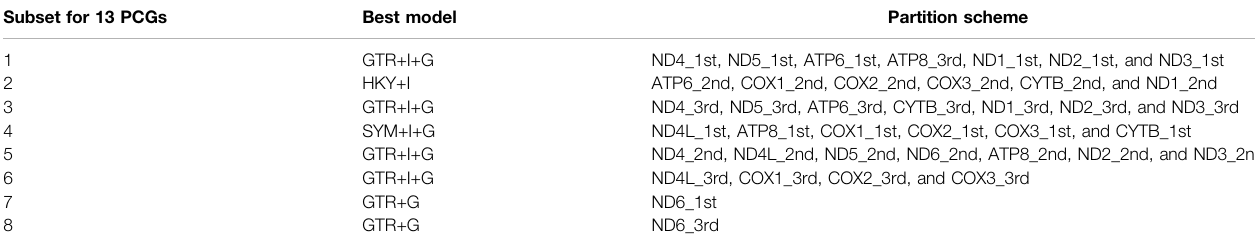
TABLE 1 | Partition scheme of 13 PCGs used in this